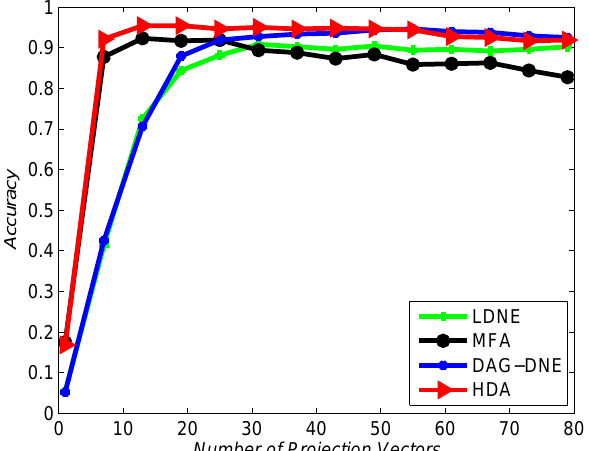
Figure 12. Accuracy vs. Number of Projection Vectors on the ORL dataset under K = 5.